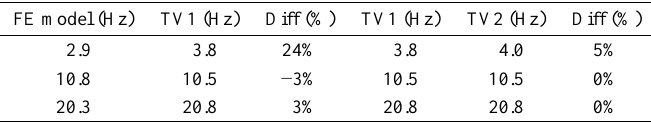
Summary of natural frequencies extracted from lateral response